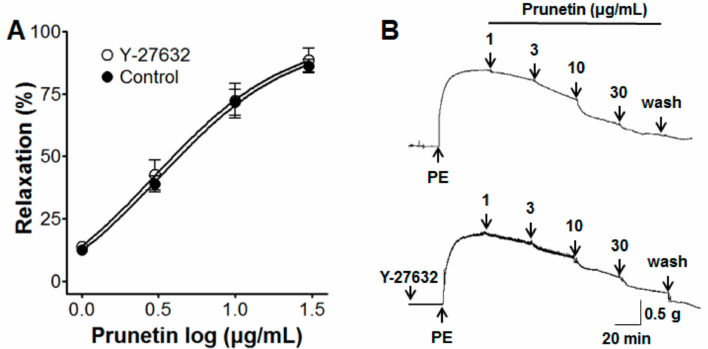
Figure 4. Concentration-response relaxation effect ( A ) and representative traces of the effect ( B ) of prunetin on endothelium-denuded aortic rings pre-contracted by phenylephrine (PE, 1 µ M) in the presence or absence (control) of Y-27632 (Rho-kinase inhibitor, 1 µ M). Values are expressed as mean ± SEM ( n =